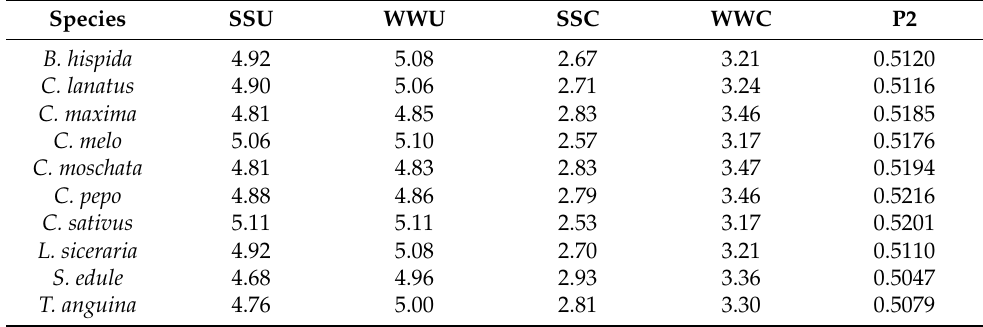
Figure 9. Plot of ENC vs. protein length in ten species of Cucurbitaceae. Note: the horizontal axis is the value of protein length, the vertical axis is the value of ENC. Table 2. The P2 analysis of CUB in ten species of